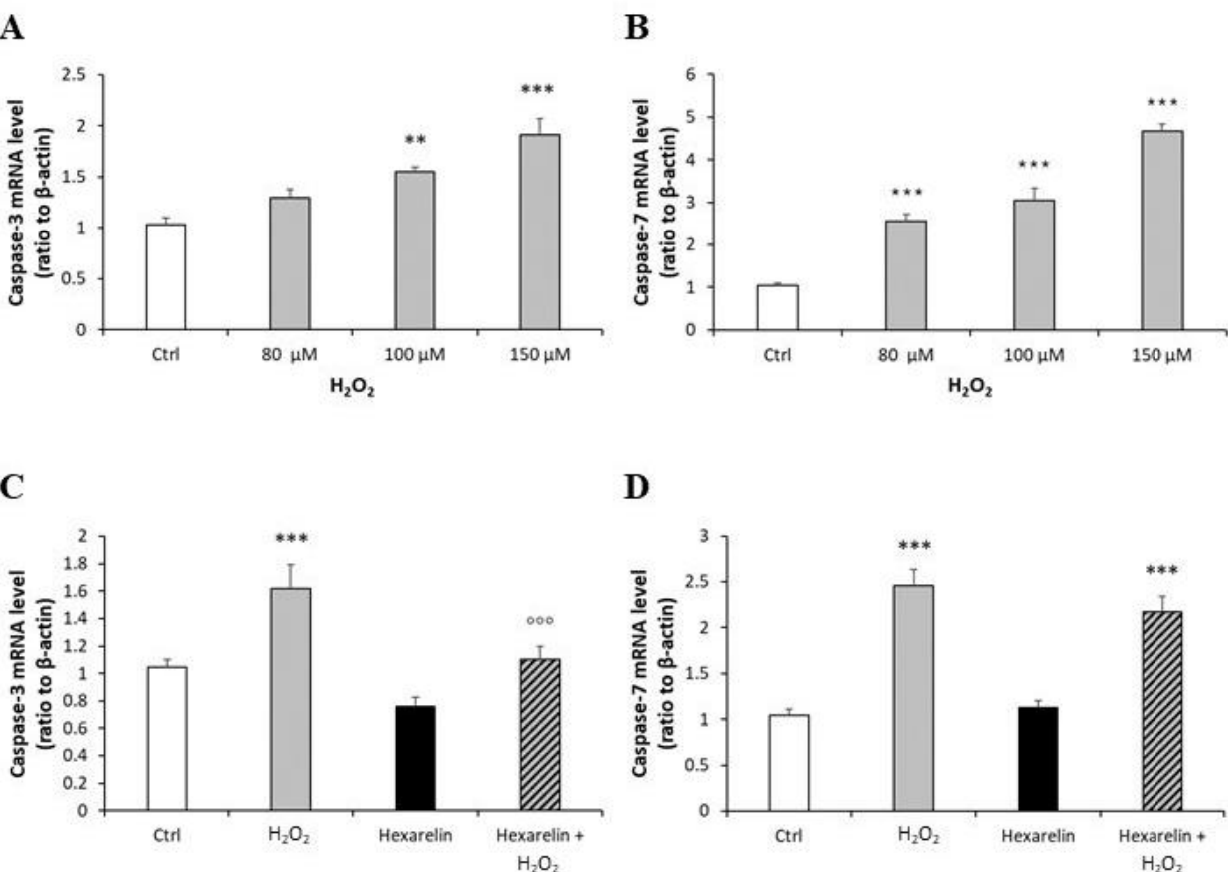
Figure 8. Analysis of caspase-3 and caspase-7 mRNA levels following H 2 O 2 exposure and their modulation induced by hexarelin. Neuro-2A cells were treated with different concentrations of H 2 O 2 (80, 100, 150 µ M) or co-incubated with 1 µ M hexarelin and 100 µ M H 2 O 2 for 24 h. Caspase-3 ( A , C ) and caspase-7 ( B , D ) mRNA levels were measured by RT-PCR and normalized for the respective β -actin mRNA levels. Data are expressed as mean ± SEM of 3 replicates ( n = 18). ** p < 0.01, *** p < 0.001 vs. CTRL; ◦◦◦ p < 0.001 vs. H 2 O 2 .